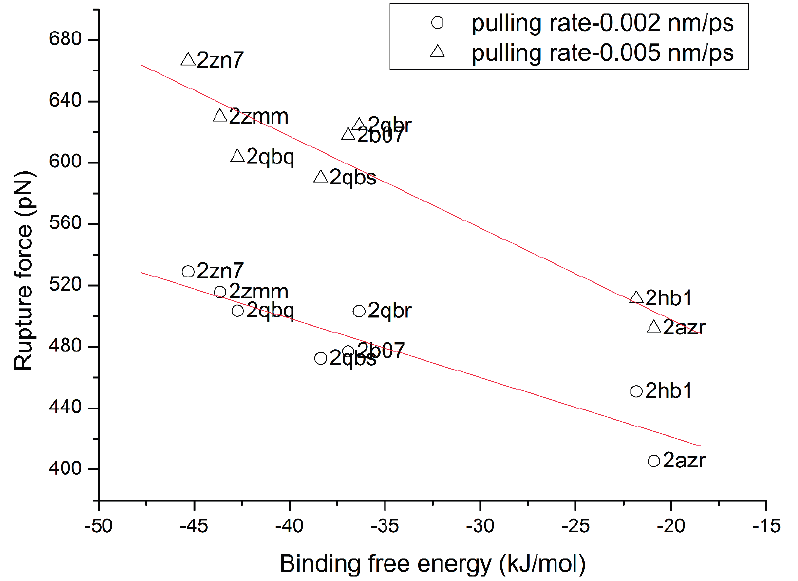
Figure 4. The influence of the pulling rate on the rupture force of the complexes in the Tyrosine-protein phosphatase